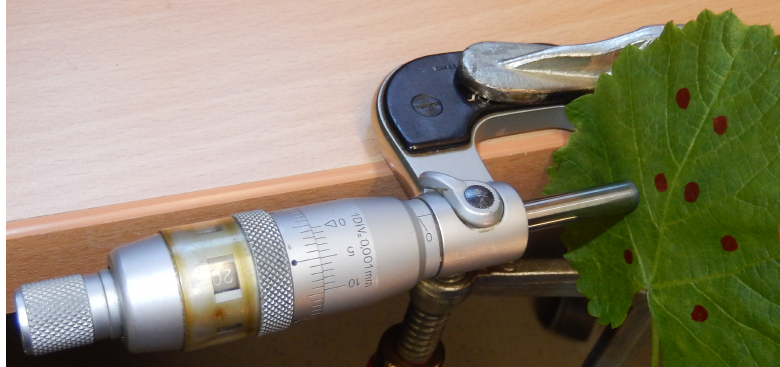
Figure 5. Measuring comparative values with an outside micrometer. The red areas represent the points P i where manual measurements were